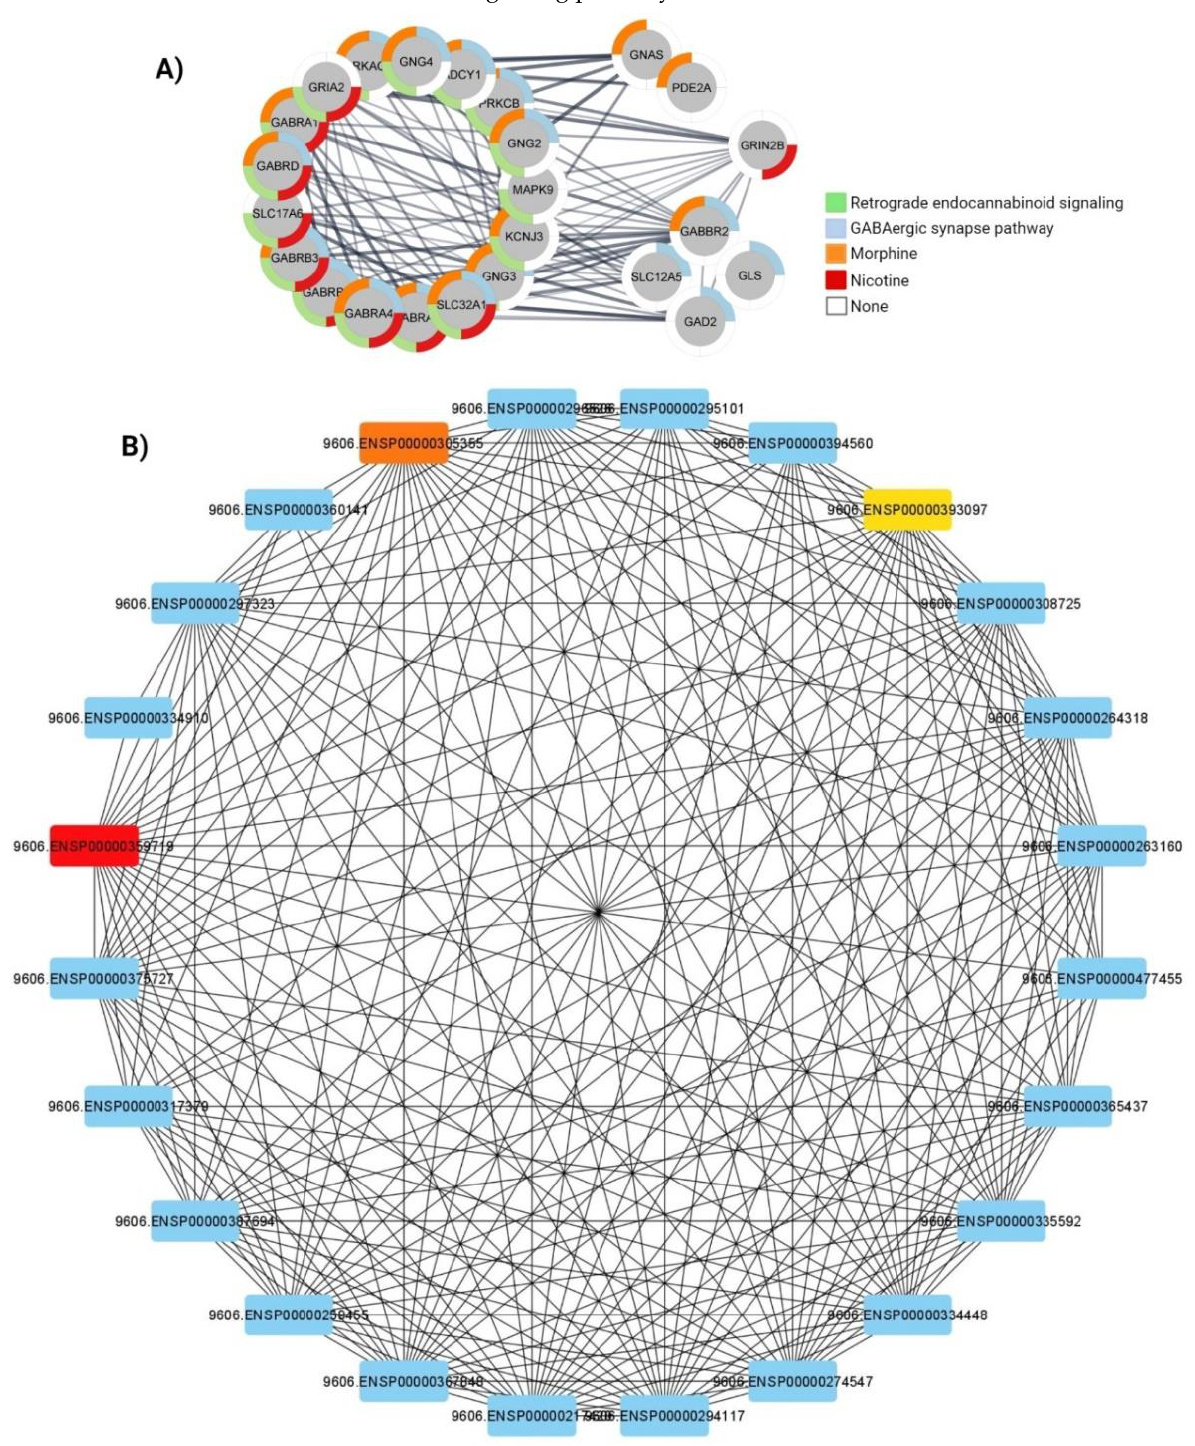
Figure 3. Functional interaction networks analyzed by the String Cytoscape plug-in. ( A ) PPI network of genes related to GABAergic synapse pathway (red), retrograde endocannabinoid signaling (green), morphine (blue) and nicotine (orange). ( B ) In addiction, PRKACB (red), PRKCB (orange) and GABRA1 (yellow) found the top hub genes based on the MCC algorithm.